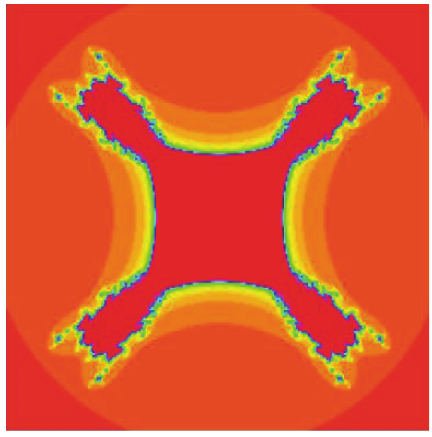
Figure 4: Relative superior tricorn for 𝑠 = 0.6 and 𝑠 󸀠 = 0.5 .